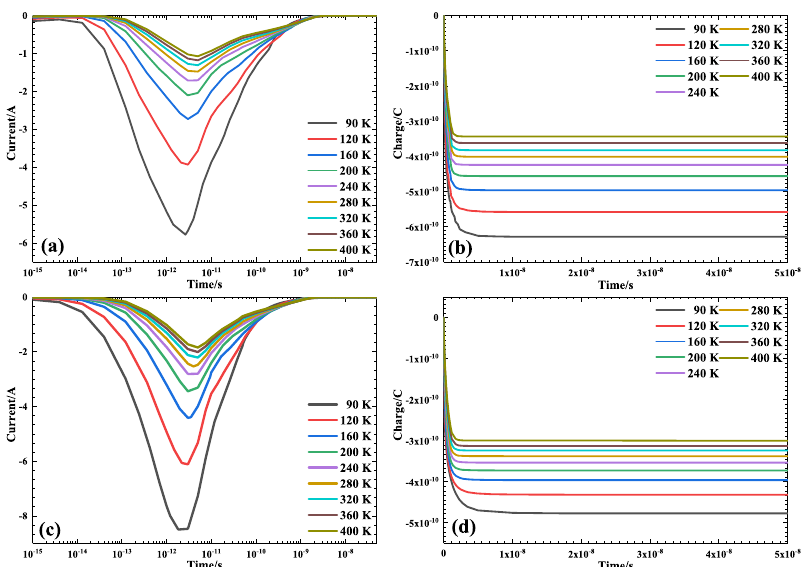
Figure 12. Change in base current and collected charge with time when heavy ions vertically irradiate the emitter ( a , b ) and base ( c , d ) of the SiGe HBT under different ambient temperatures.